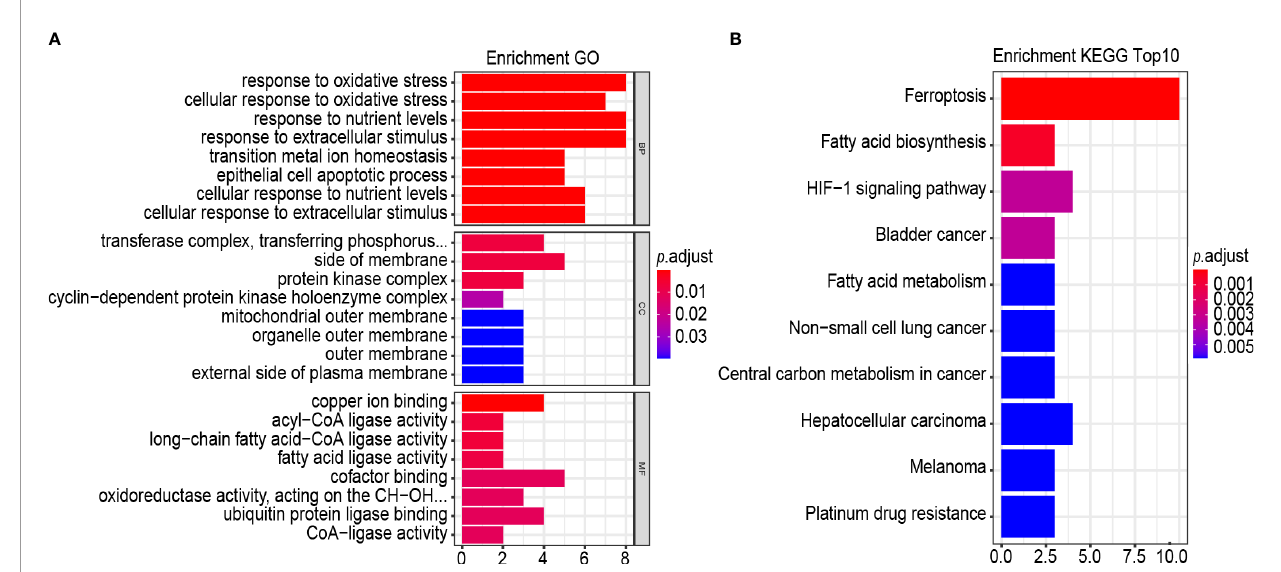
FIGURE 8 | GO, and KEGG analysis. (A, B) Functional annotation of 25-gene using GO terms and KEGG pathway. GO (A) and KEGG (B) . “ BP ” stands for “ biological process ” , “ CC ” stands for “ cellular component ” , and “ MF ” stands for “ molecular function ”